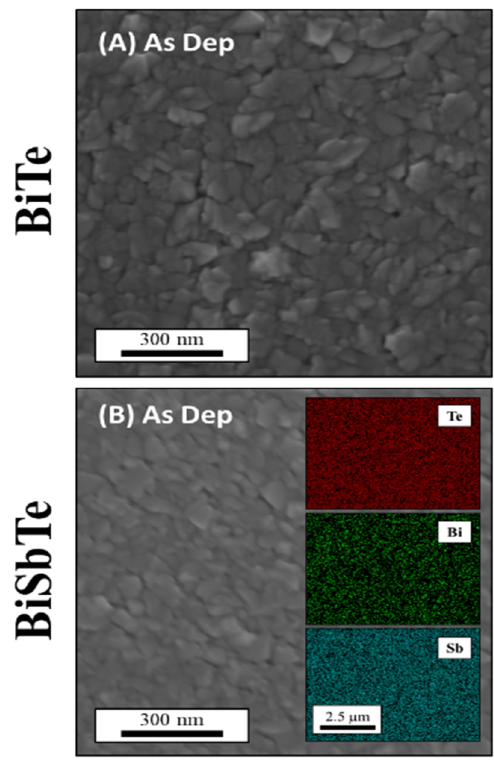
Figure 2. ( A ) As dep BiTe and ( B ) As dep BiSbTe micrographs of surfaces for thermoelectric coatings. Individual grains and grain boundaries are clearly present in both As dep compositions. EDX mapping as shown in ( B ) compositional mapping suggested uniform elemental dispersion.